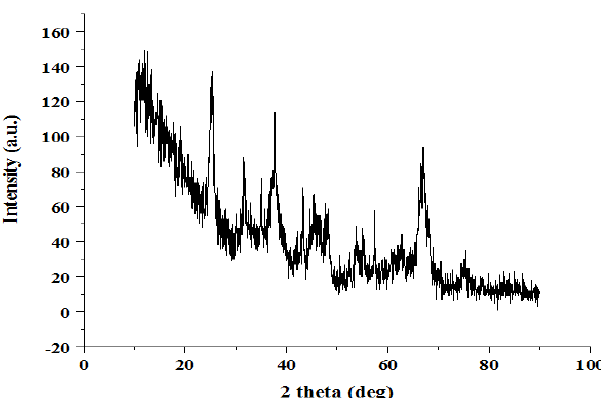
Fig. 1. XRD pattern of TiO calcined at 800 °C.